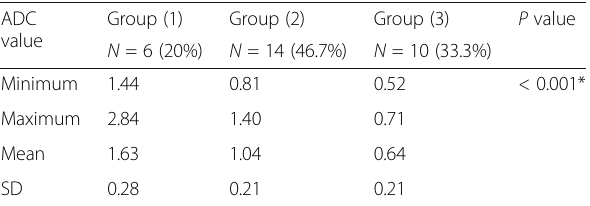
Table 3 Comparison of mean ADC value between the studied groups, the values are expressed in 10 − 3 mm 2